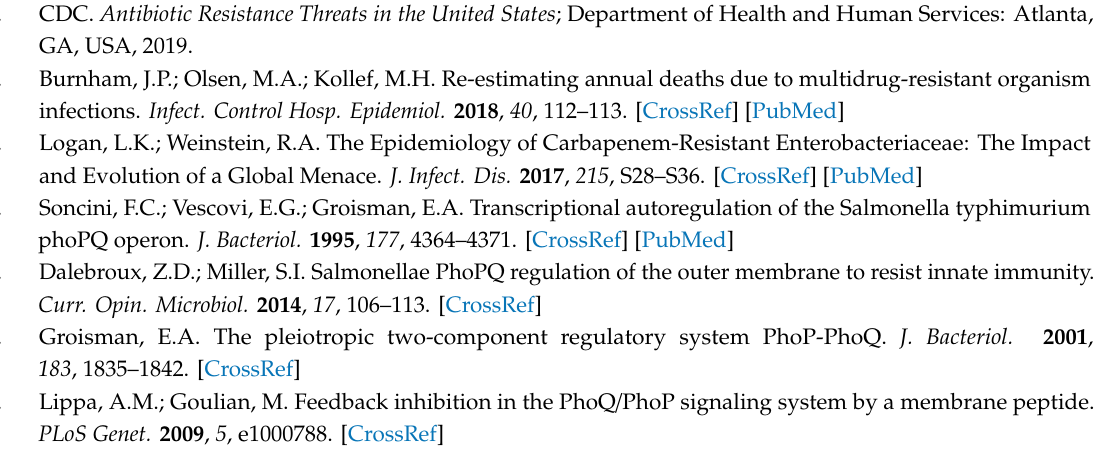
Figure S1: Absence of mgrB in the Mu471 genome, Table S1: Broth microdilution of Mu471, Mu471 p mgrB , ATCC13047, ATCC13047 ∆ mgrB